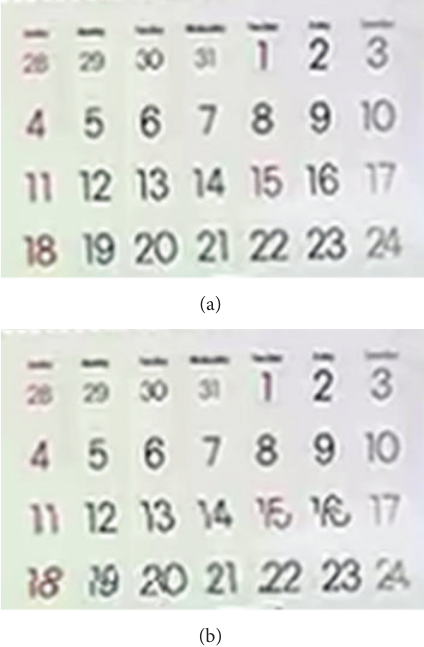
Figure 13: Effect of decrease on NQI by 0.0613.